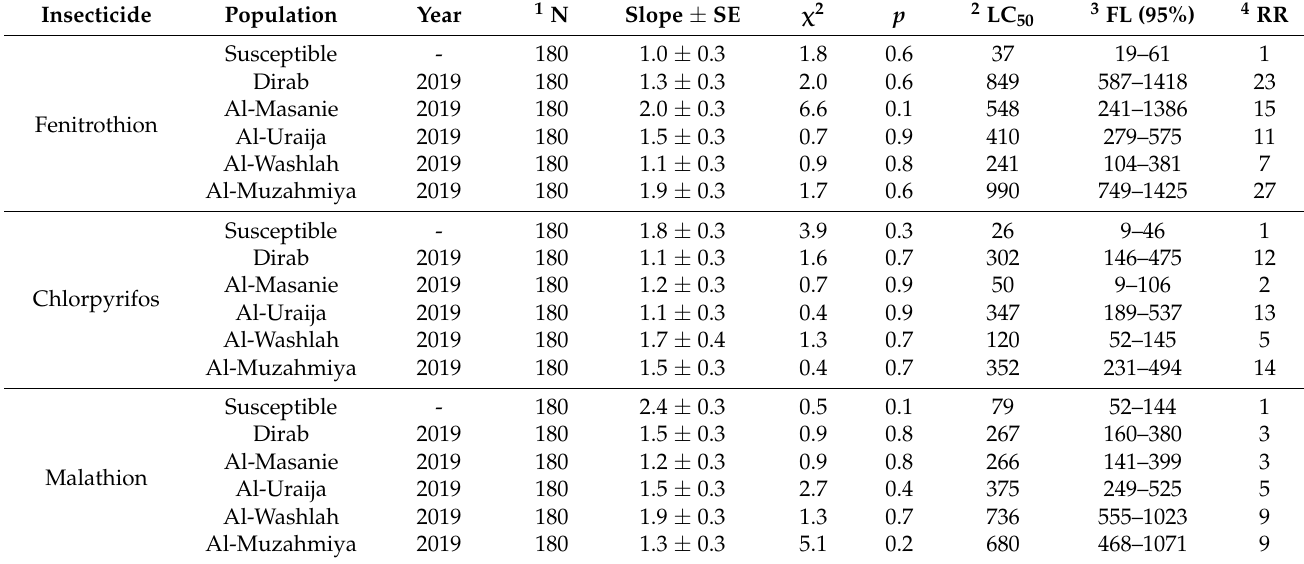
Table 3. Toxicity of organophosphates in adult female house flies from different dairy